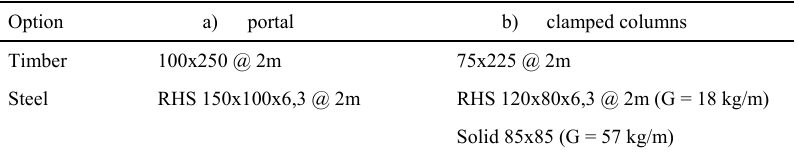
Table 2: Proposed options for structural elements.